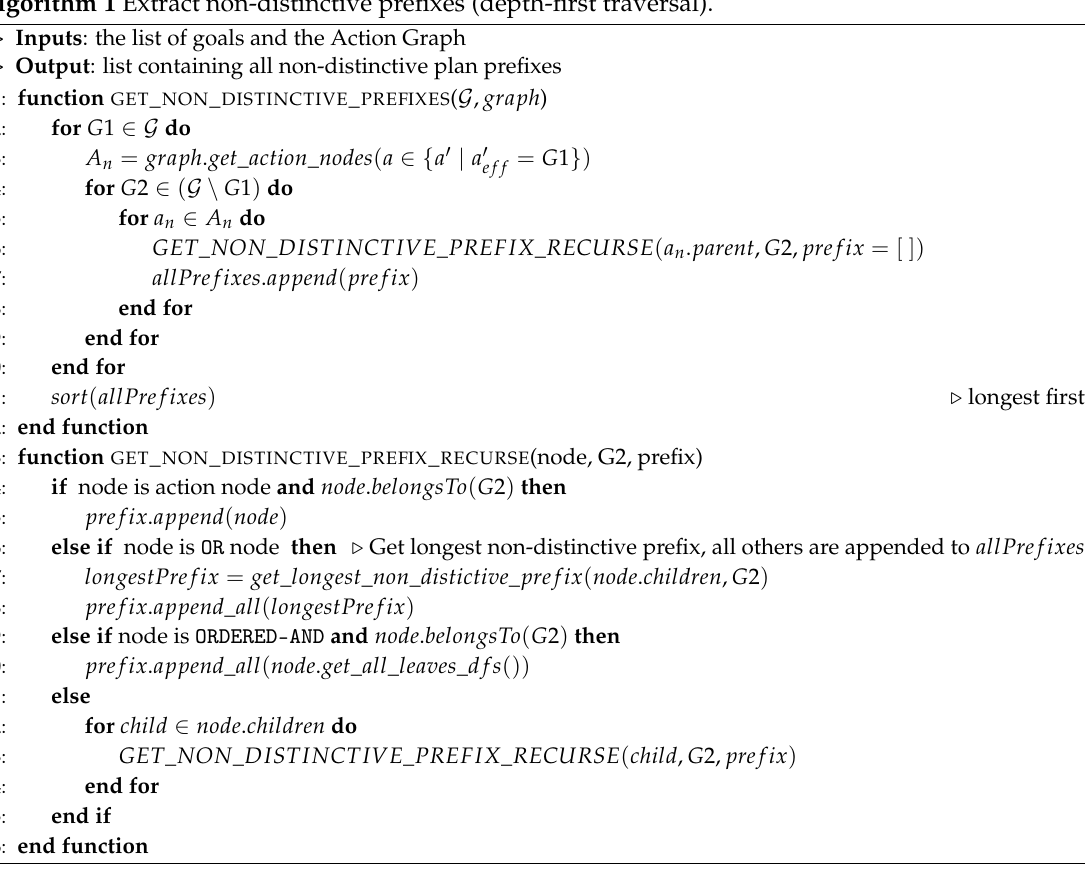
Algorithm 1 Extract non-distinctive prefixes (depth-first